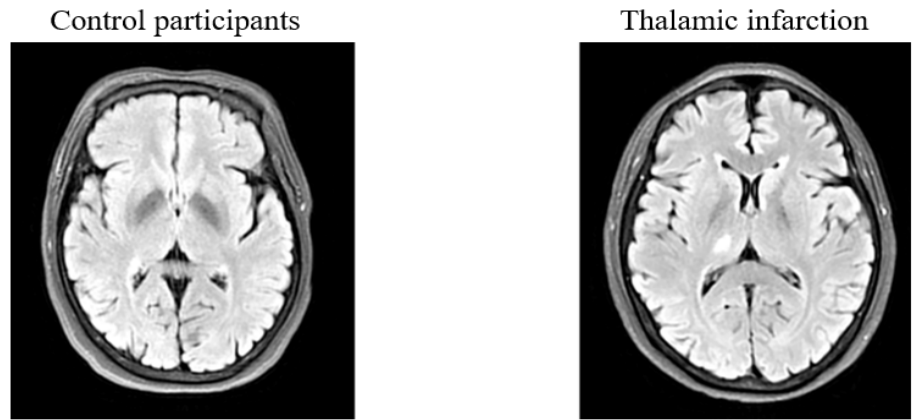
Figure 1. Representative MR imaging of thalamic infarction patient and control participant. The right image shows a fluid-attenuated inversion recovery (FLAIR) MR image of a patient with an ischemic stroke lesion beside the right thalamus, while the left image shows a FLAIR image of control.